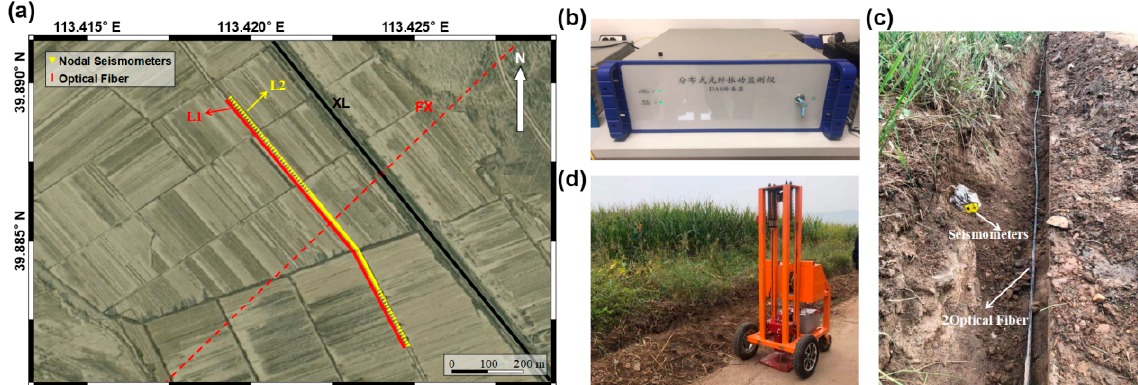
Figure 2. Scene of field deployments of the distributed optical fiber and seismometers. ( a ) shows the location of optical fiber and nodal seismometers line; the ground of the test site is flat with little fluctuation. ( b ) shows the DAS interrogator used in this paper. ( c ) is the horizontal trenching of a DAS cable and three-component nodal seismometers at the surface. ( d ) is the small tamping machine used in this experiment.